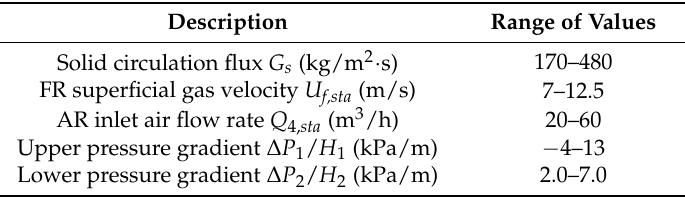
Table 2. Main operation conditions of the iG-CLC